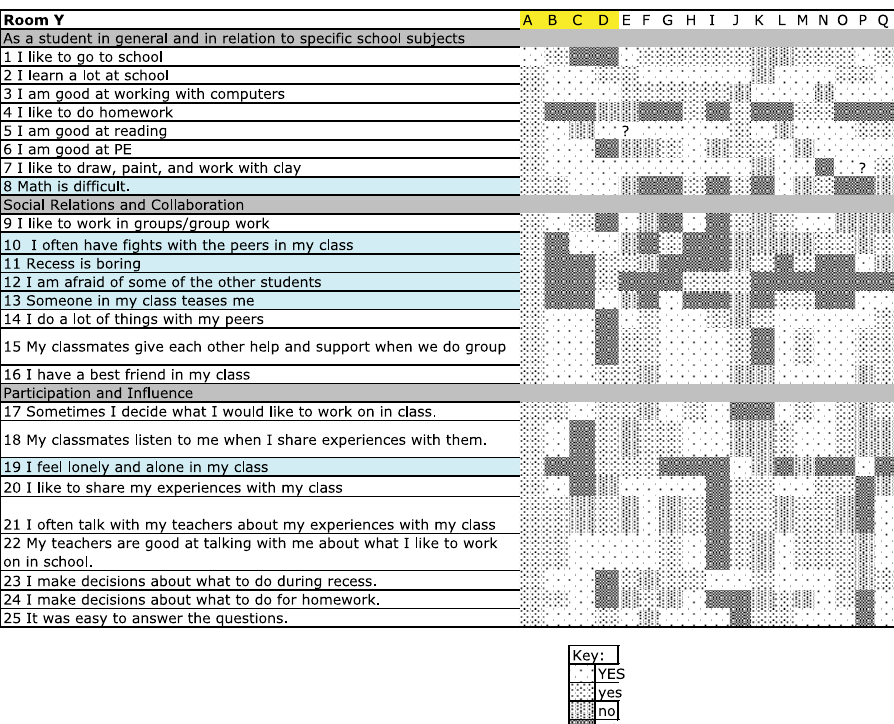
Figure 1. Summary of fifth graders perceptions of their